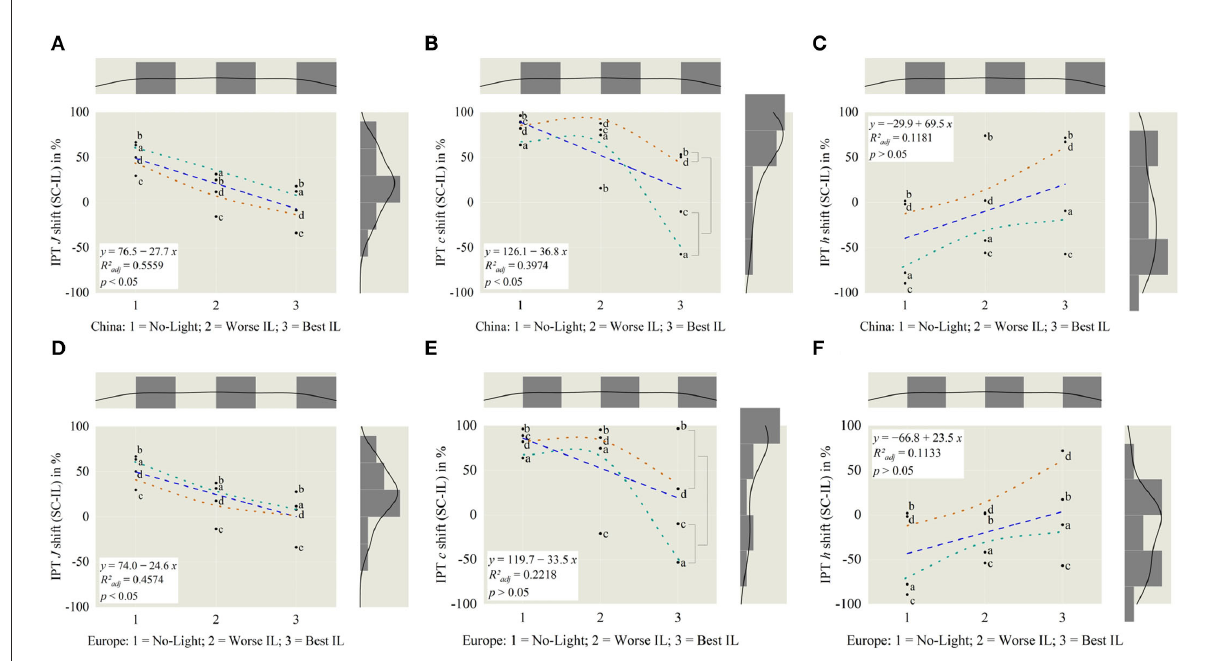
FIGURE9 Based on China in IPT, for (A) lightness J = − 26.5 and (B) chroma c = − 31.8, slopes are significantly different from zero, resulting in a tendency from worst to best illumination. For (C) hue h = 21.8, the slope is not different. Tendency lines are added for sun city, a-marking in green and night, d-marking in brown. For reference (D–F) , IPT dimensions from Europe .